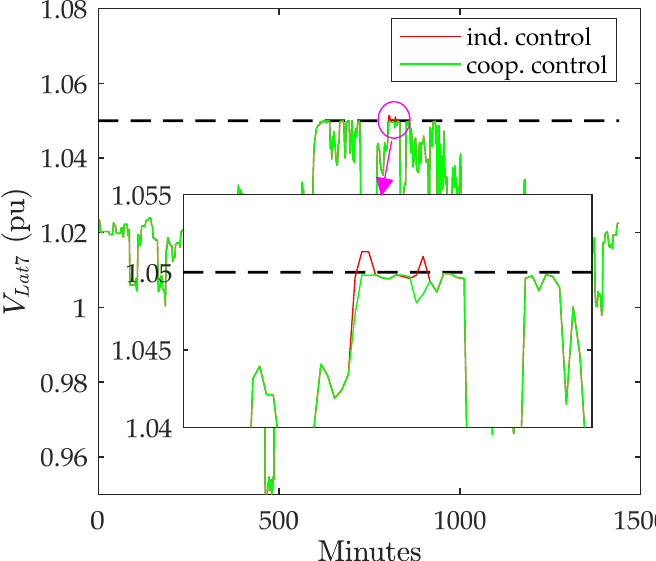
Figure 17. Voltage on lateral 7 with individual control and cooperative control.